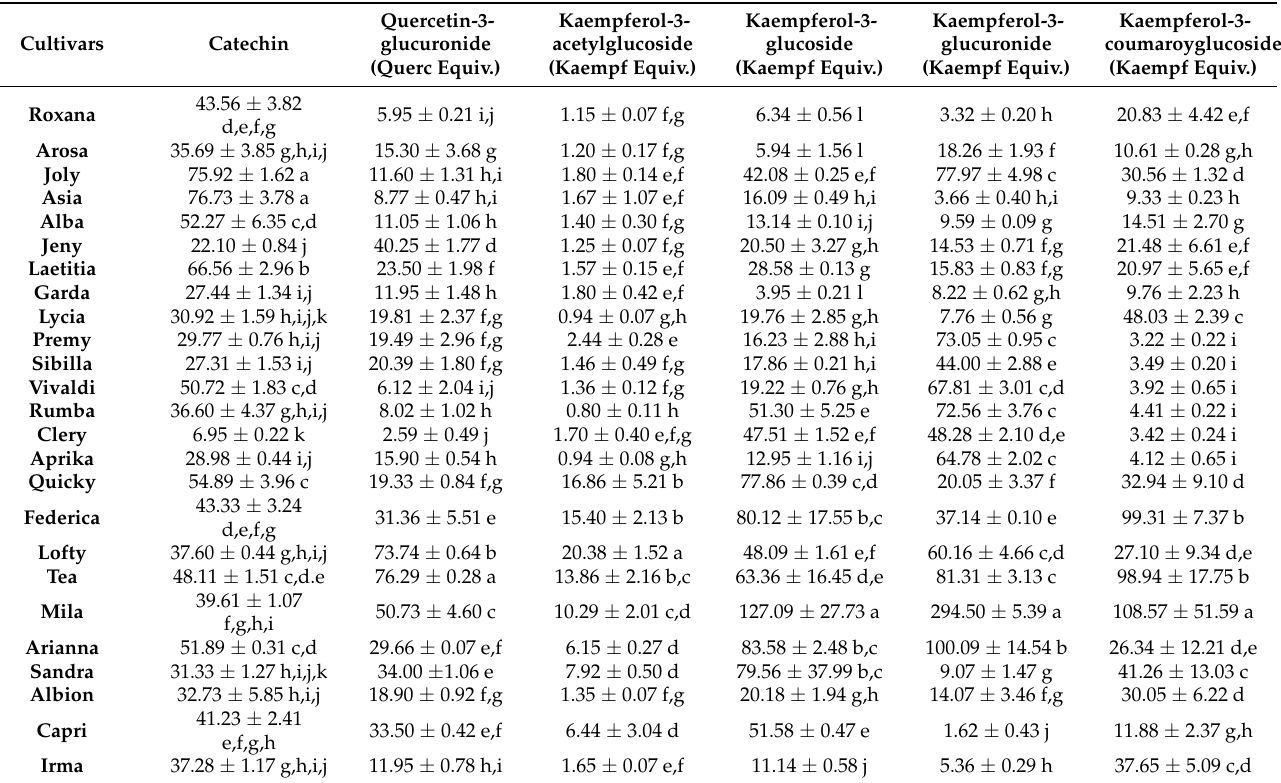
Table 5. Content ( µ g g − 1 of FW) of flavonols and flavan-3-ols in strawberry fruit